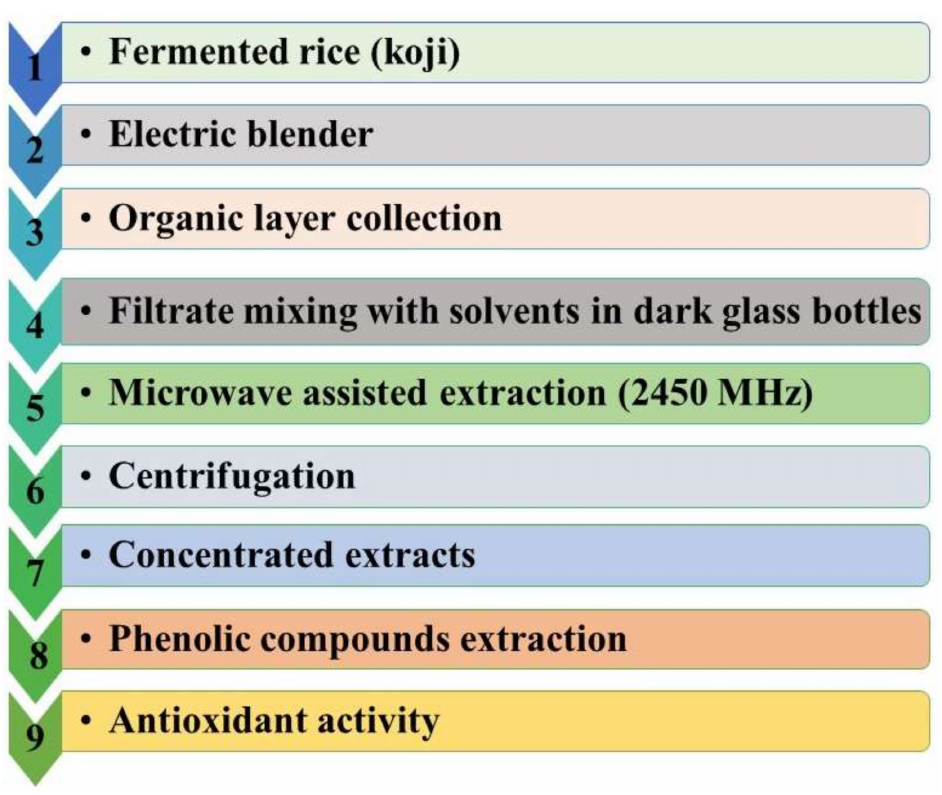
Figure 3. Diagram showing a summary of the proposed methodology used to extract phenolic compounds and antioxidant activity